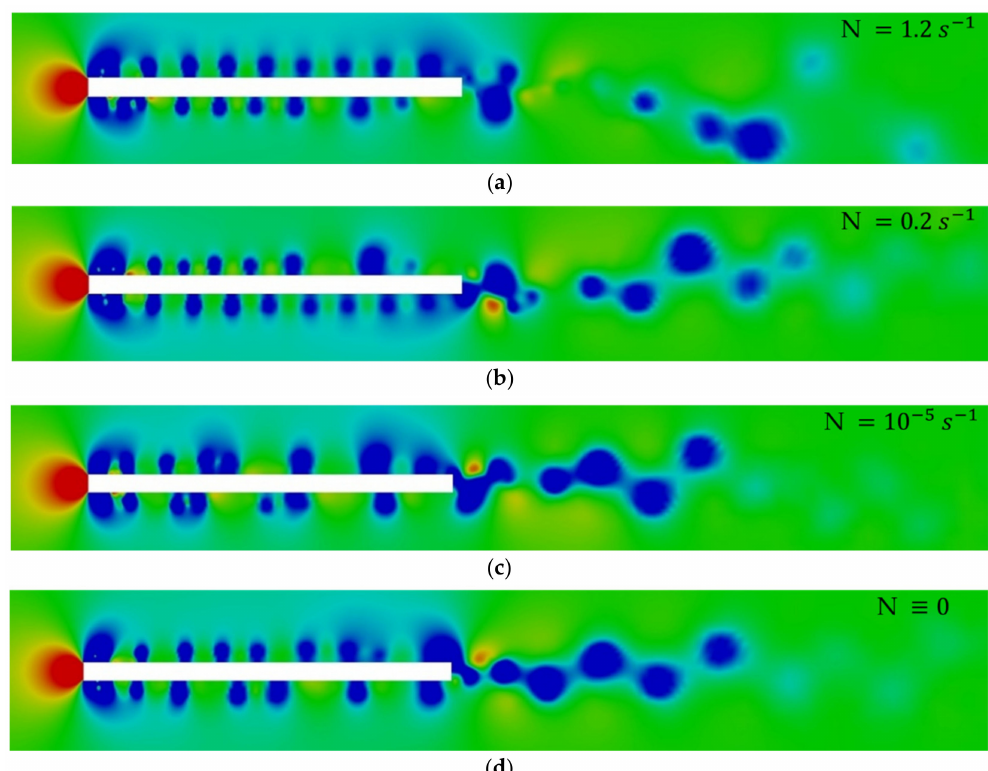
Figure 13. Instantaneous patterns of pressure field around uniformly moving horizontal plate ( L = 10 cm, U = 80 cm/s, = 5.25 s, N = 1.2 s − 1 (cid:1) and weakly (cid:0) T = 31.3 s, N = 0.2 s − 1 (cid:1) stratified fluids, potentially α = 0 ◦ ): ( a – d )—Strongly (cid:0) T b b (cid:0) (cid:1) T b = 6.23 · 10 5 s, N = 10 − 5 s − 1 and actually ( T b = ∞ , N = 0 ) homogeneous ones, red and blue colors in the color spec- trum correspond to positive and negative values of the pressure perturbation field within the range, − 100 < P < 100 Pa and green color is zero